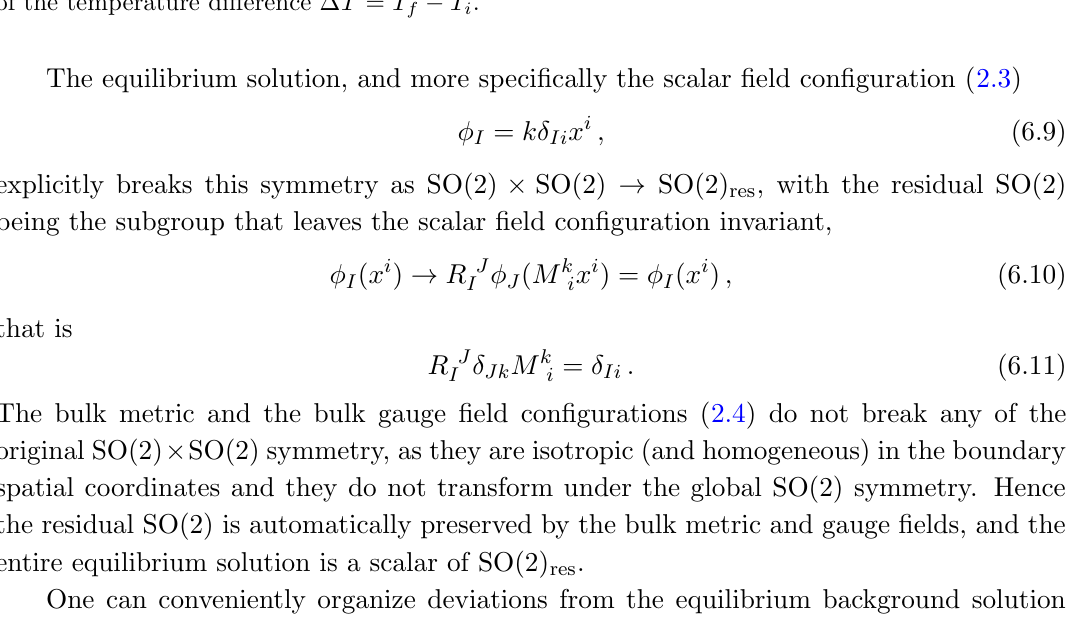
Figure 13 . The maximum deviation of the DC conductivity from its thermalized value as a function of the temperature di(cid:11)erence (cid:1) T = T f (cid:0) T i